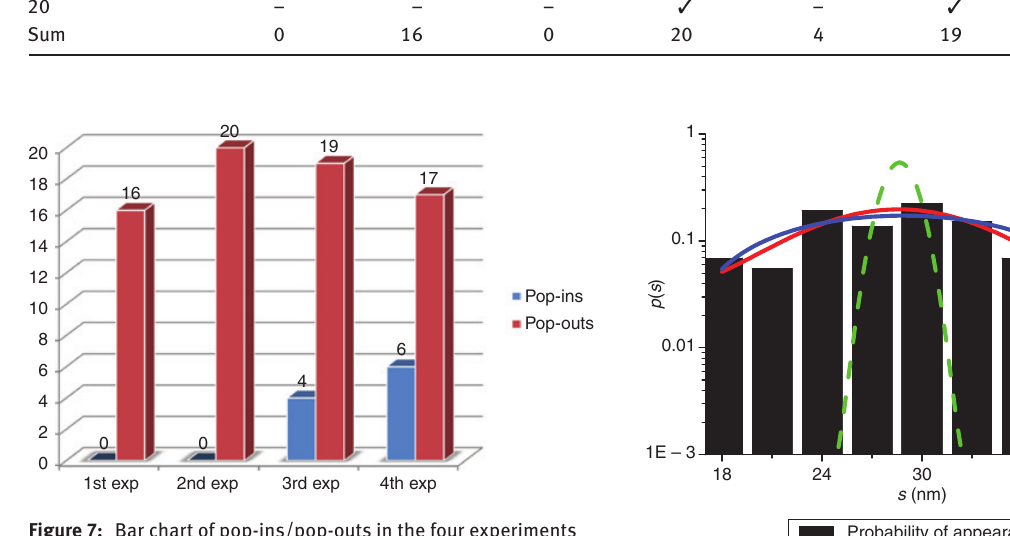
Figure 7: Bar chart of pop-ins/pop-outs in the four experiments